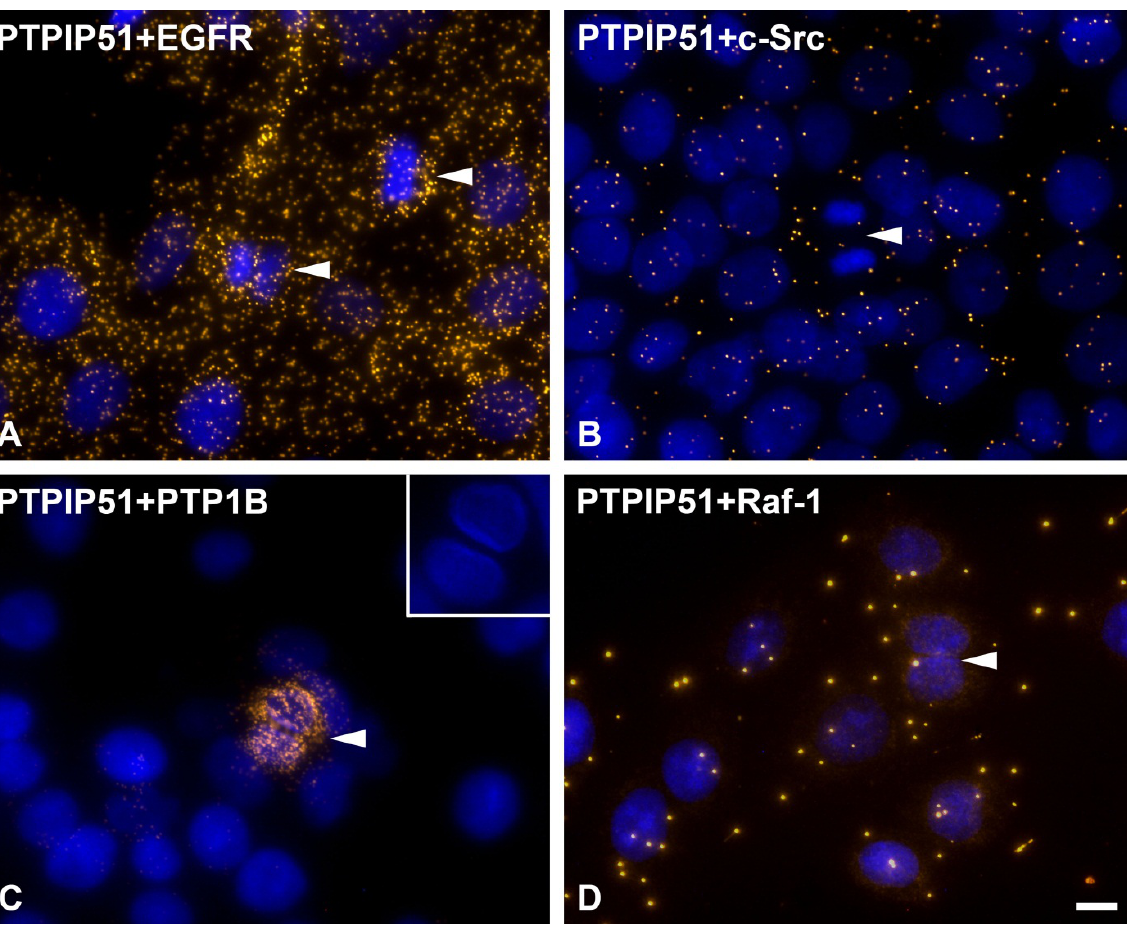
Figure 10. DPLA of the interaction partners of PTPIP51: EGFR, c-Src, PTP1B and Raf-1. ( A ) DPLA of PTPIP51 and EGFR. Mitotic cells are marked by arrows. ( B ) DPLA of PTPIP51 and c-Src. Arrow: mitotic cell. ( C ) DPLA of PTPIP51 and PTP1B. Dividing cell is marked by the arrow. The inset shows the nuclei of the dividing cell marked by the arrow. ( D ) DPLA of PTPIP51 and Raf-1. Dividing cell is marked by the arrow. PTPIP51 antibody: P51ab. Nuclei are marked by Dapi. Bar: 10